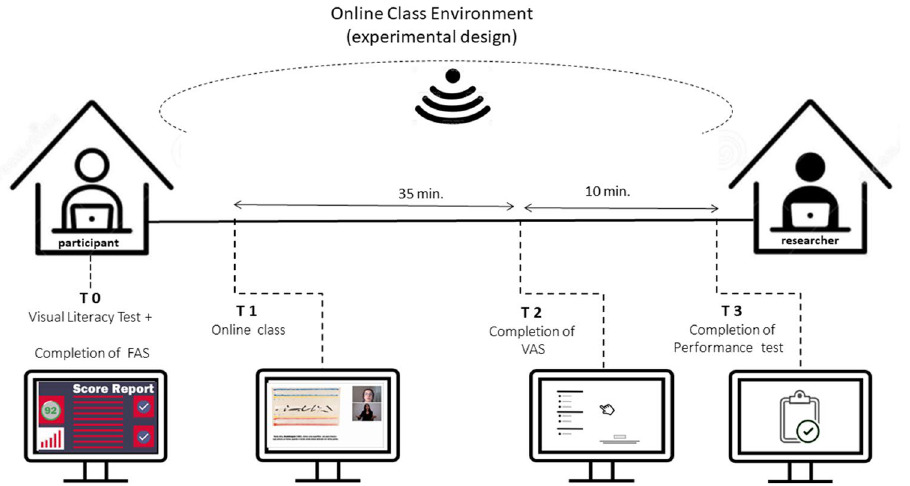
Figure 1. Experimental design (sequence and